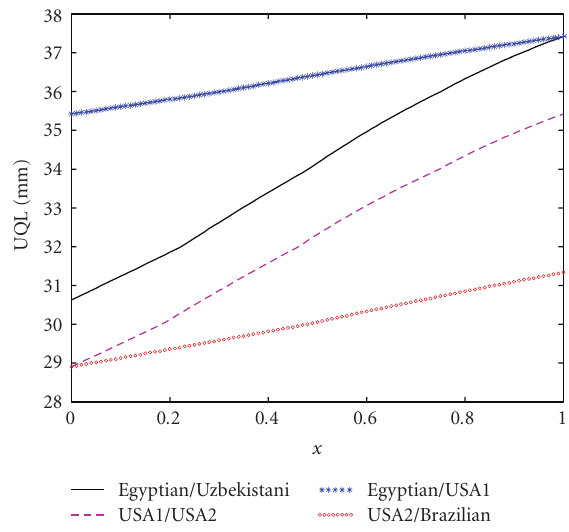
Figure 1: ML dependence to x . Figure 2: UQL dependence to x